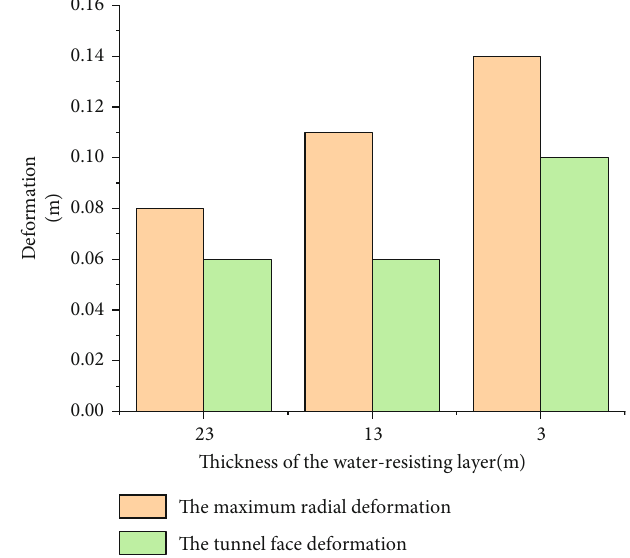
Figure 6: Deformation of tunnel under di ff erent thickness of water-resisting layer.